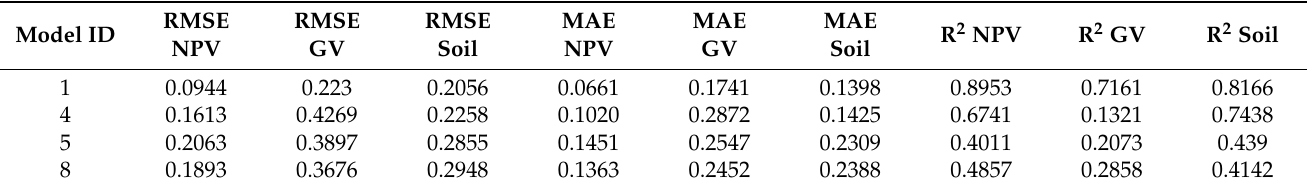
Figure A1. Endmember spectral curves for the four optimized spectral libraries: ( a ) EMC; ( b ) inCOB; ( c ) IES; ( d ) Reduced IES. Errors in the 1300–1500 nm and 1800–2000 nm range are due to atmospheric absorption windows. Table A2. Accuracy assessment report for all fraction images that were able to be assessed, with root mean square error (RMSE), mean average error (MAE), and R 2 values reported for NPV, GV, and soil. Refer to Appendix A for Model ID correspondences with parameter adjustments.